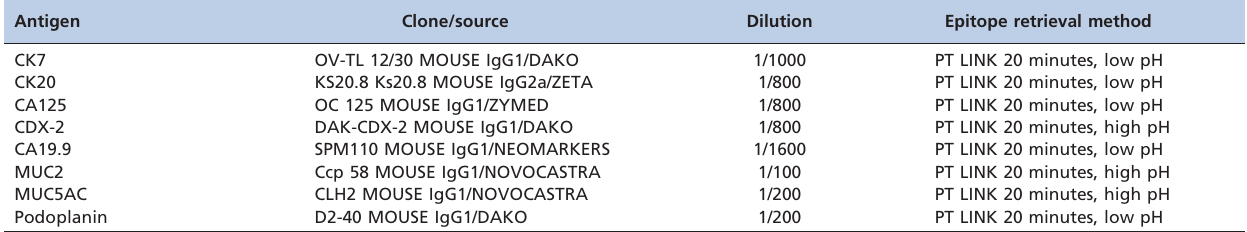
Table 2 - Reagents and methods used for immunohistochemical analyses. Antigen